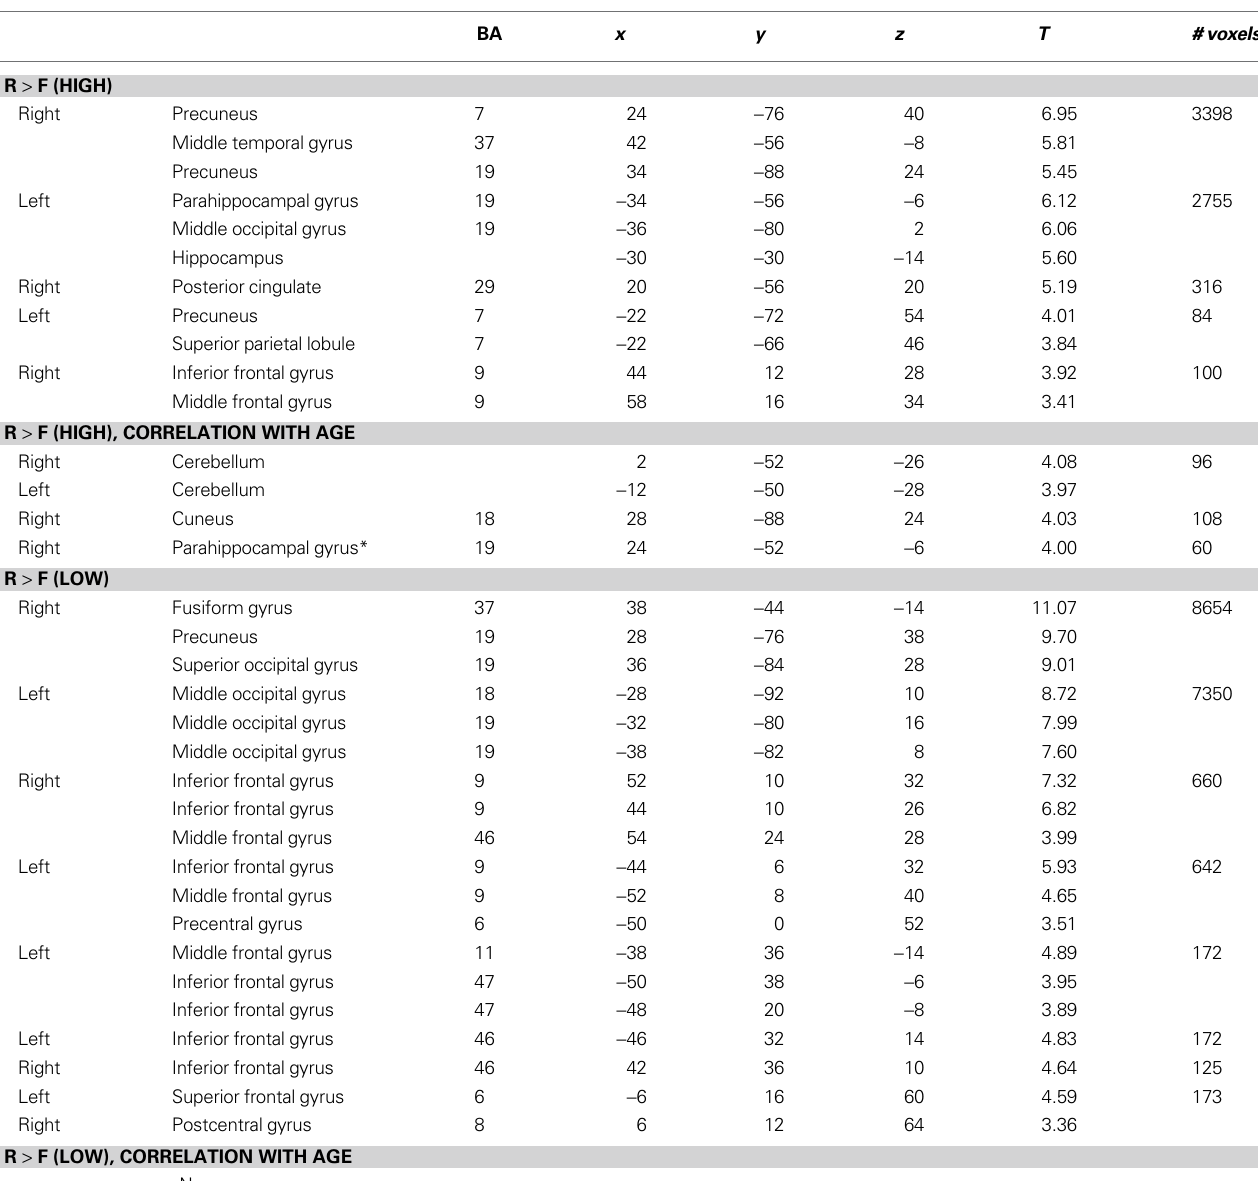
Table 2 | Subsequent memory activations for remembered